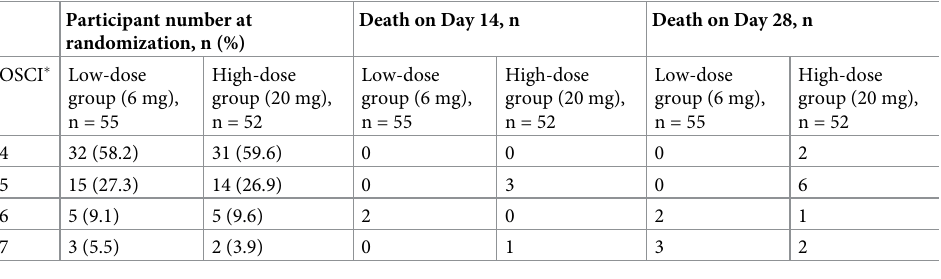
Table 3. Day 14 and day 28 death in WHO-Ordinal scale for clinical improvement (WHO-OSCI)